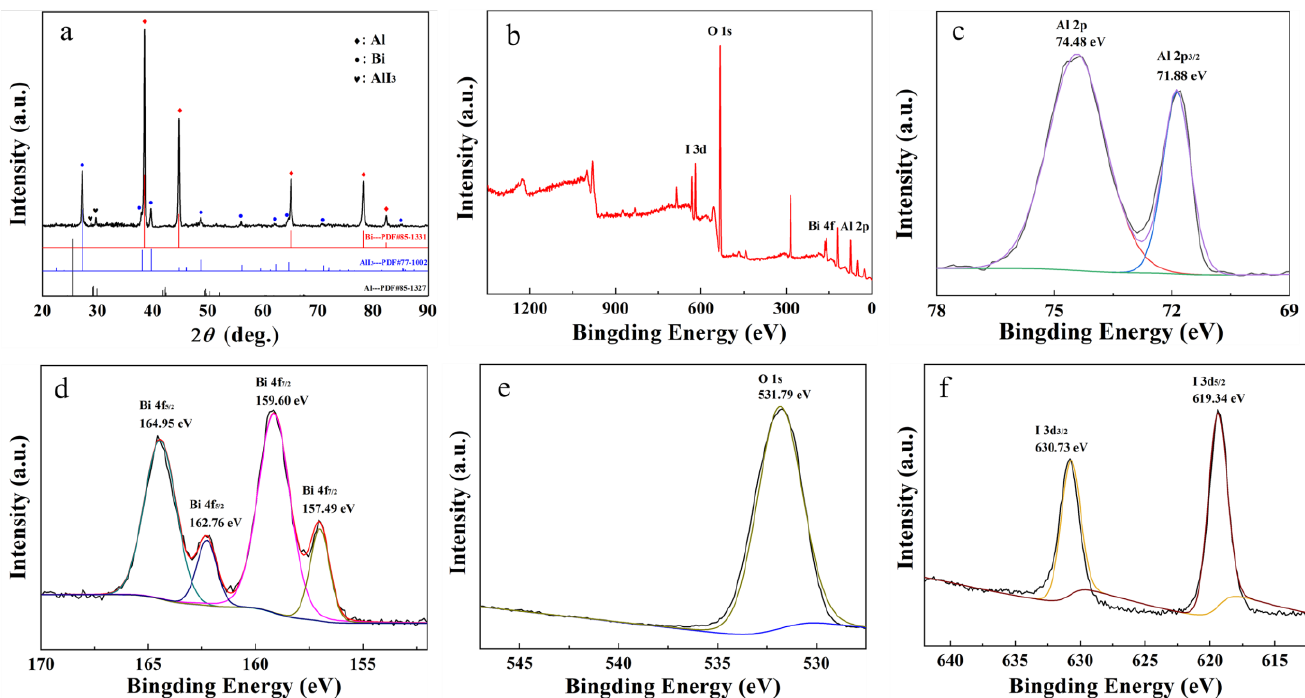
Figure 6. Characterization of Al-BiOI, ( a ) XRD; ( b – f ) XPS curves.